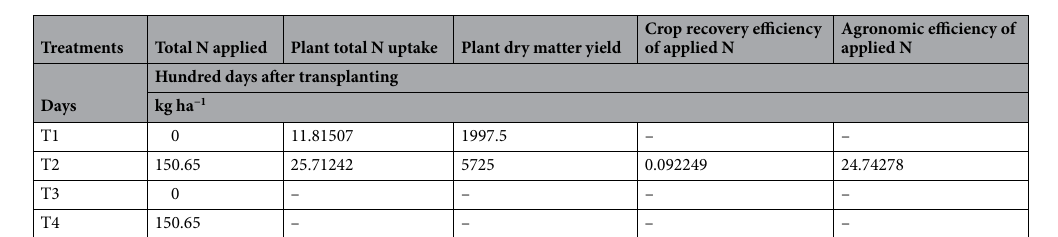
Table 23. Chicken litter biochar application and split application of urea on crop recovery and agronomic efficiency on day one hundred after transplanting.